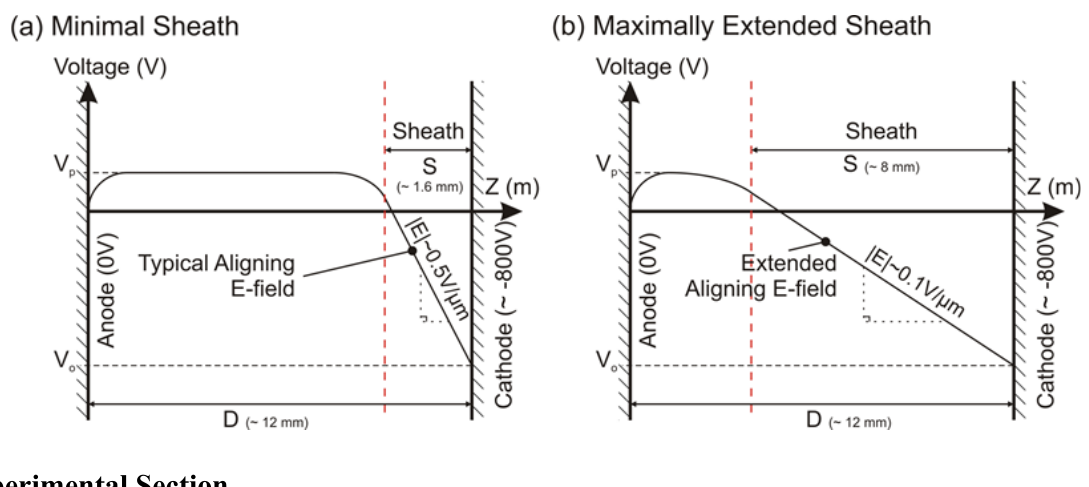
Figure 6. Illustrative examples of ( a ) typical and ( b ) optimal sheath width highlighting. The magnitude of the associated lateral electric